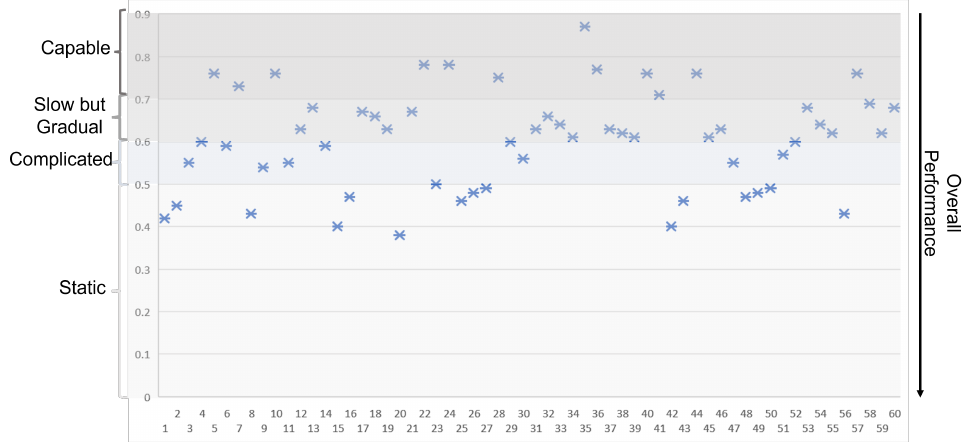
Figure 1. Users’ profiling based on the comparison with an optimal